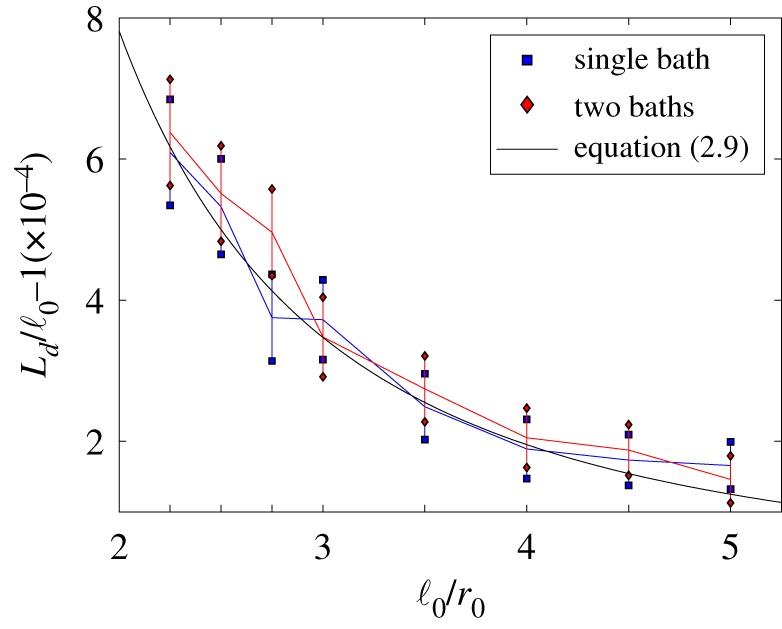
The extension of the average length of a dimer from its separation distance ℓ0. The equilibrium data for each model was collected from a long-time simulation of length 100 dimensionless time units where Δt = 10−6 and the monomers were initially placed with separation ℓ0. The values of α = ℓ0/r0 presented are {2.25, 2.5, 2.75, 3, 3.5, 4, 4.5, 5}. The parameters used are r0 = 0.08, γ = 10, D = 1, μ = 103 and k = 106. In the one-bath case, we use L = 0.72 for the frame (3.10) enclosing the whole dimer, and for the two-bath case, we use L = 0.32 for each monomer frame.